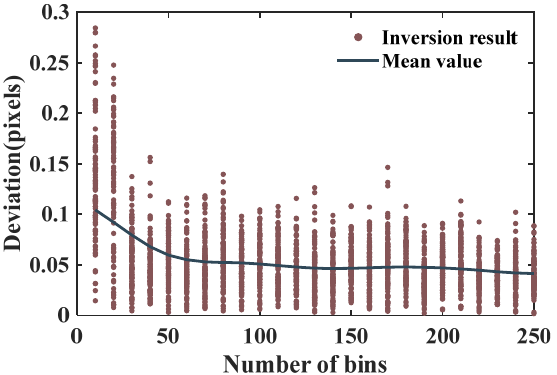
Figure 5. The deviation of the interferogram center using the MSDM with different numbers of bins.